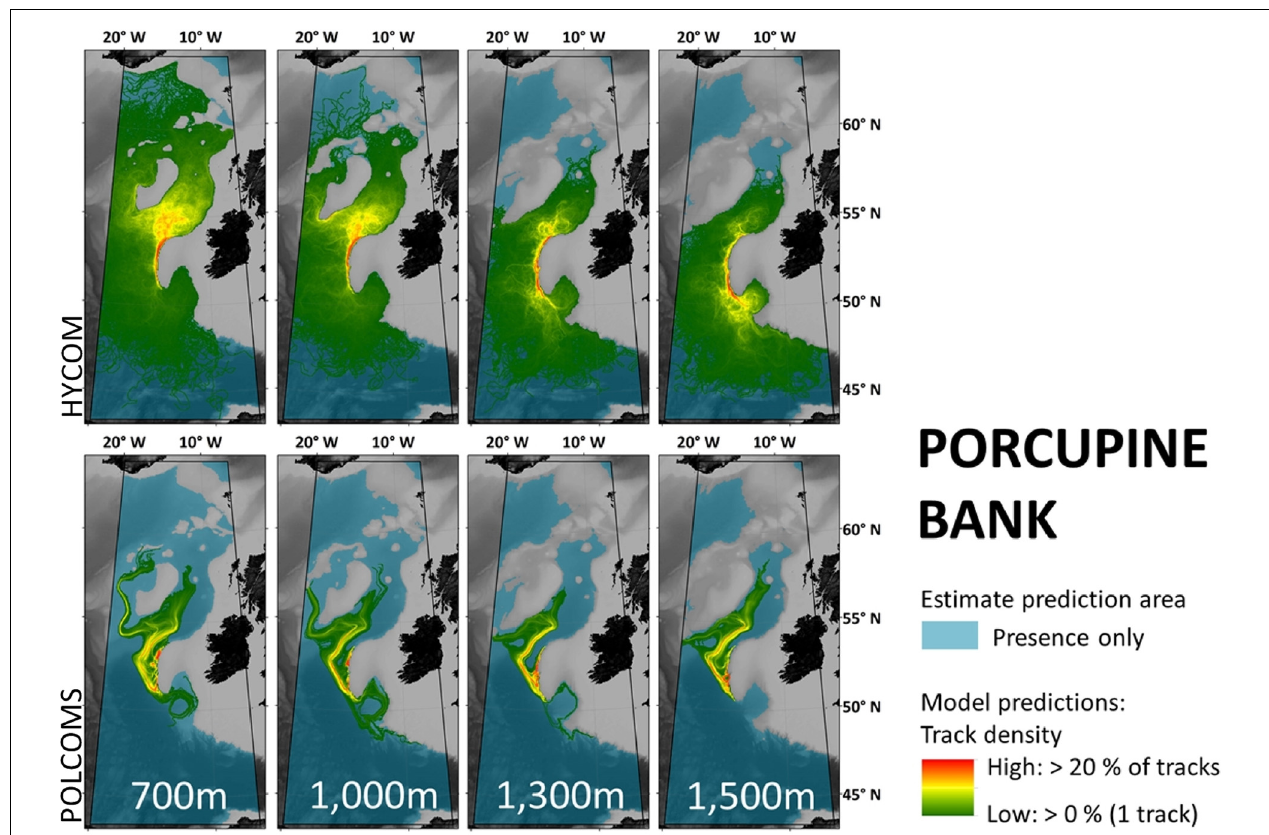
FIGURE 5 | Maps per depth band of predicted larval dispersal as simulated from Porcupine Bank. Simulations from HYCOM and POLCOMS models are displayed as track densities delineating between occasional and persistent pathways of dispersal. All estimate prediction areas fill the POLCOMS domain but differ between maps due to the 2D nature of simulations excluding areas of raised topography. Spatial correlations were conducted comparing the extent of modeled and estimated predictions and the extent and density information of each modeled prediction ( Table 2 ). [All maps were created in ArcGIS 10.3 (http://www.esri.com) with GEBCO 30 arc-second topography, available from www.gebco.net, and projected using Albers Equal Area Conic with modified standard parallels and meridian (sp 1 = 46 ◦ N, sp 2 = 61 ◦ N, m = 13 ◦